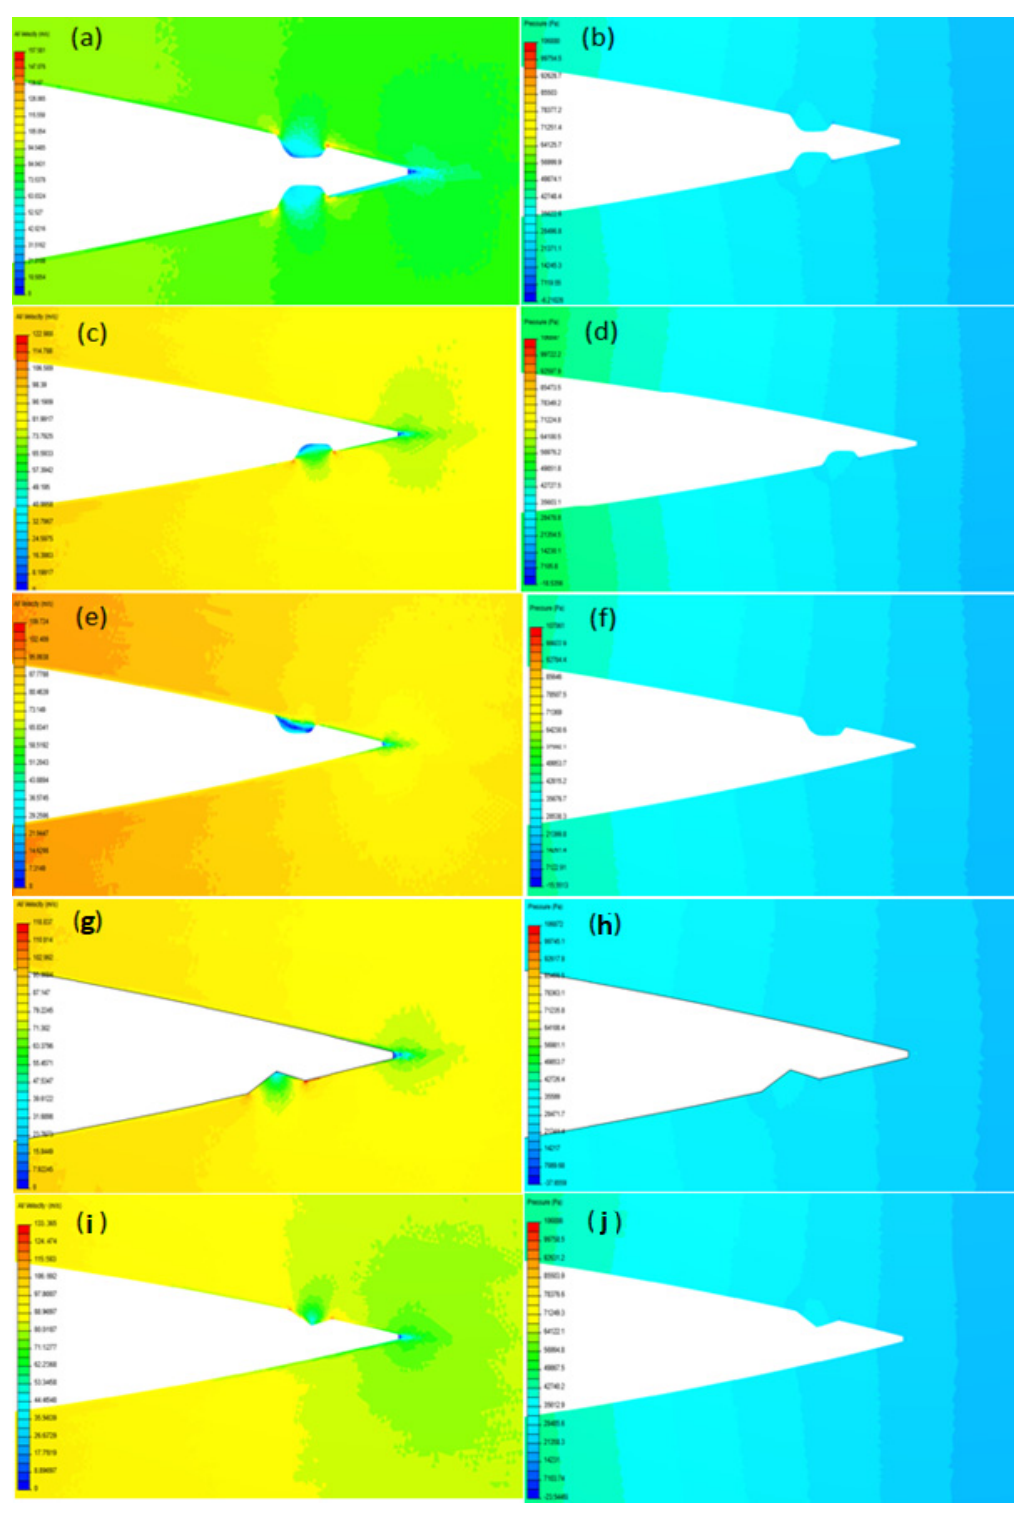
Figure 22. Exploded view showing ( a ) velocity profile on round dimple on both ends, ( b ) pressure profile on round dimple on both ends, ( c ) velocity profile on round bottom dimple, ( d ) pressure profile on round bottom dimple, ( e ) velocity profile on round top dimple, ( f ) pressure profile on round top dimple, ( g ) velocity profile on triangle bottom dimple, ( h ) pressure profile on triangle bottom dimple, ( i ) velocity profile on triangle top dimple, and ( j ) pressure profile on triangle top dimple.